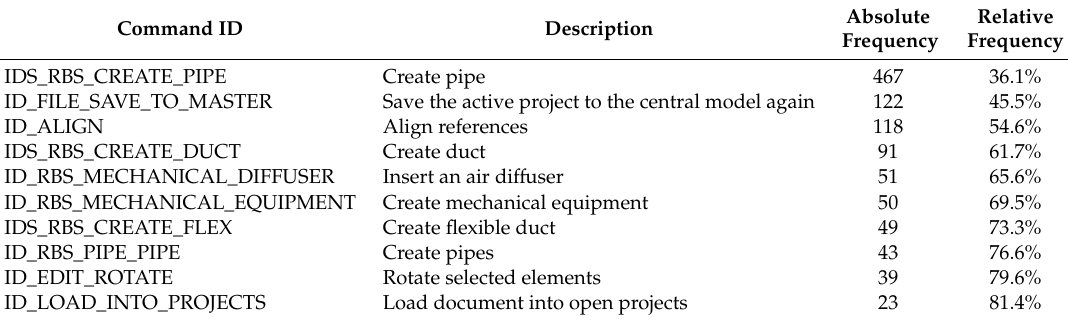
Table A2. Contributory commands most frequently used by the mechanical designer.